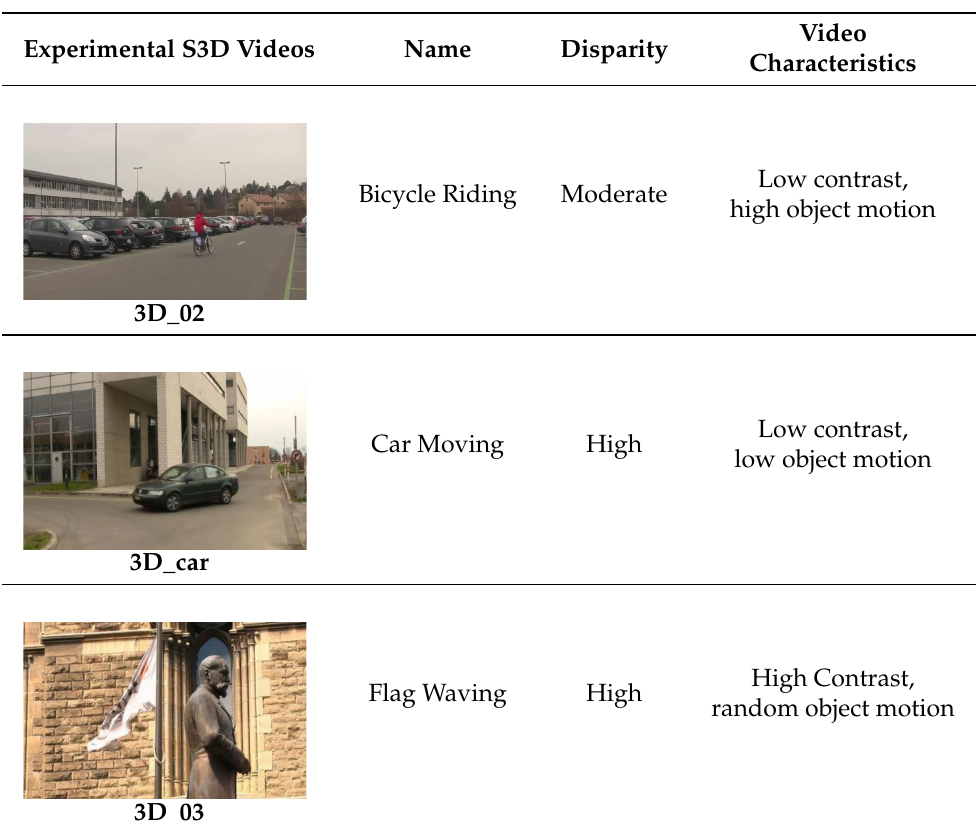
Table 1. Experimental video